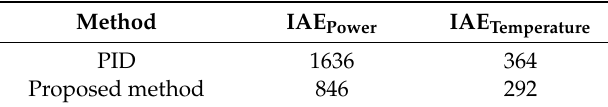
Table 3. Performance indices for Figure